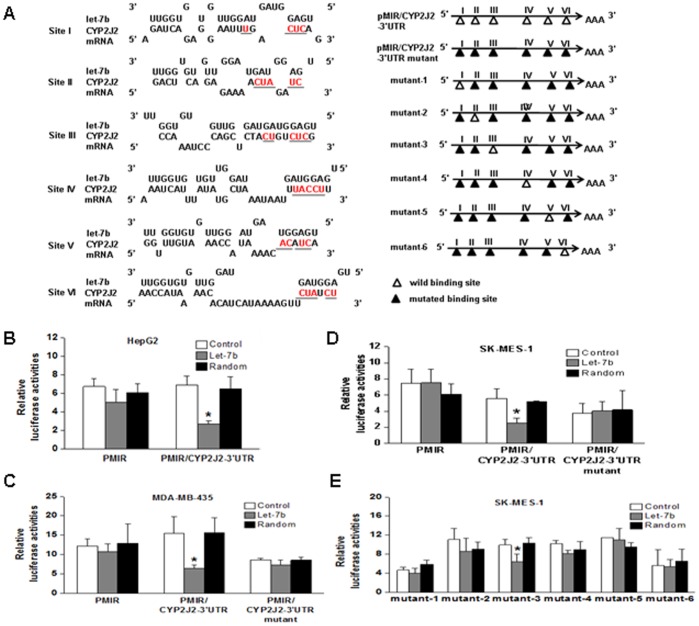
Identification of CYP2J2 as a direct target of let-7b.
A, schematic representation of the predicted target sites of let-7b in the 3′UTR of CYP2J2. The 3′UTR of CYP2J2 was cloned into a luciferase reporter plasmid, termed pMIR/CYP2J2-3′UTR. A series of mutants carried mutated nucleotides in six potential binding sites for the let-7b seed region were generated based on wild type pMIR/CYP2J2-3′UTR. Mutants of pMIR/CYP2J2-3′UTR are constructed by mutating the complementary site (labeled by underline) in the let-7b seed region to their complementary bases. B, luciferase activity was analyzed in HepG2 cells 24 h after transfection with reporter plasmid pMIR/CYP2J2-3′UTR or pMIR (empty vector). C–D, full-length sequence CYP2J2-3′UTR containing mutant binding sites for the let-7b seed region were generated based on wild type pMIR/CYP2J2-3′UTR. We transfected these constructs into the cells (MDA-MB-435 and SK-MES-1) and analysed luciferase reporter activity. As we expected, let-7b did not affect luciferase activity of mutants compared with wild type. E, the six mutants were transfected into SK-MES-1 cells, in addition to let-7b or random let-7b. The luciferase activity of the six mutants was not repressed by let-7b. Renilla luciferase activities were used to normalize firefly luciferase activity. Columns, mean of three experiments; bars, SD. *, P<0.05.